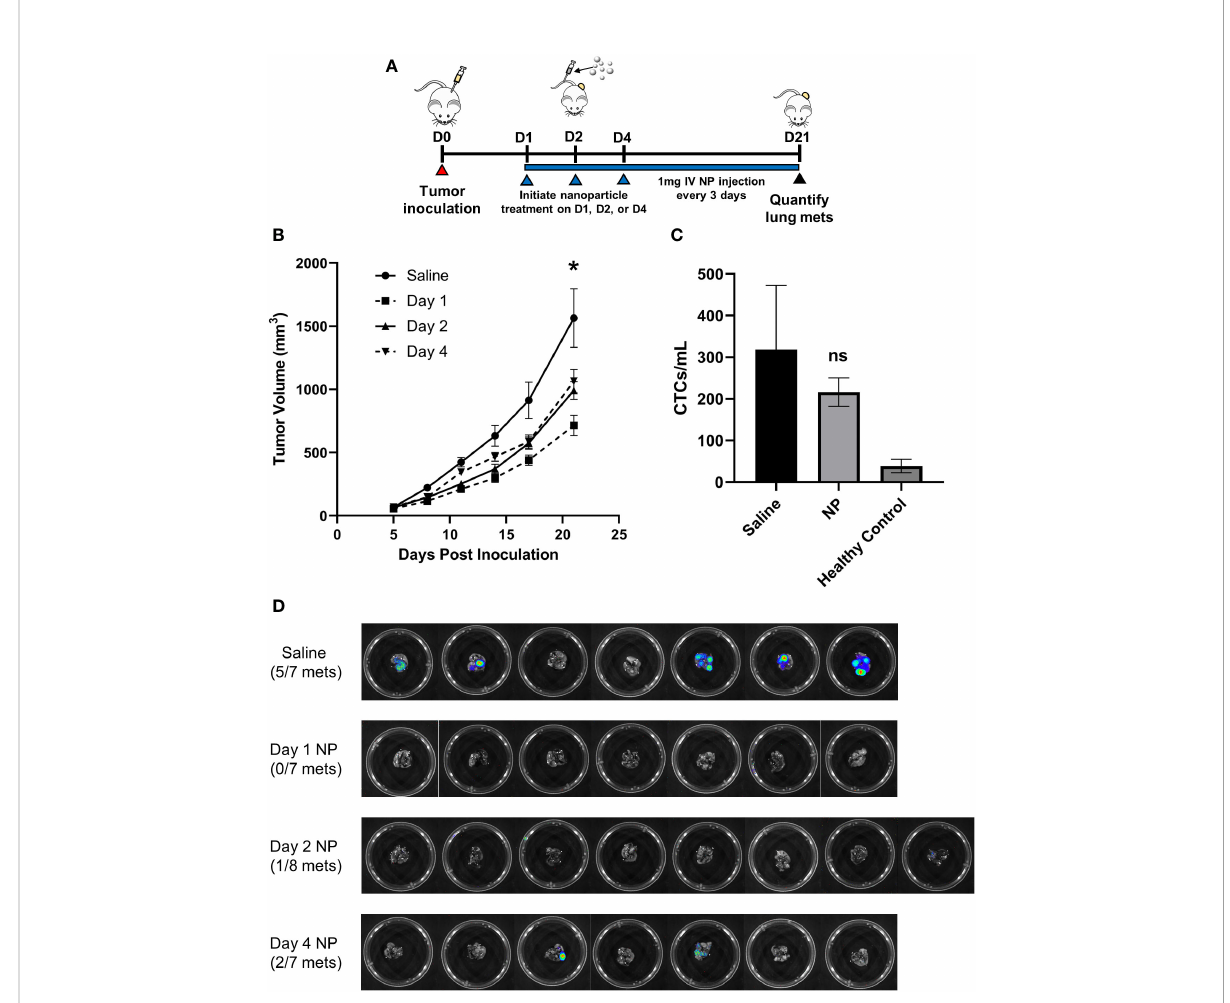
FIGURE 1 In vivo administration of cargo-free NPs inhibits 4T1 tumor growth and reduces metastatic colonization of the lungs. (A) BALB/c mice (n=7-8 per group) were inoculated with 4T1 tumor cells and intravenously administered NPs every 3 days starting on D1, D2, or D4 post-tumor inoculation, or saline as the control. (B) Longitudinal PT volumes. (C) Total CTCs in the peripheral blood of 4T1 tumor-bearing mice (n=6) receiving NPs, normalized to blood volume, did not signi fi cantly differ from mice receiving saline (n=6, p=0.51). (D) Lung metastases in 4T1 tumor-bearing mice (n=7-8 per group) were quanti fi ed with bioluminescent imaging on D21 post-tumor inoculation. Two-tailed unpaired t- tests assuming unequal variance were performed for single comparisons between two conditions. Bars show mean ± SEM. * p ≤ 0.05 compared to Day 1 NP, ns p > 0.05 compared to